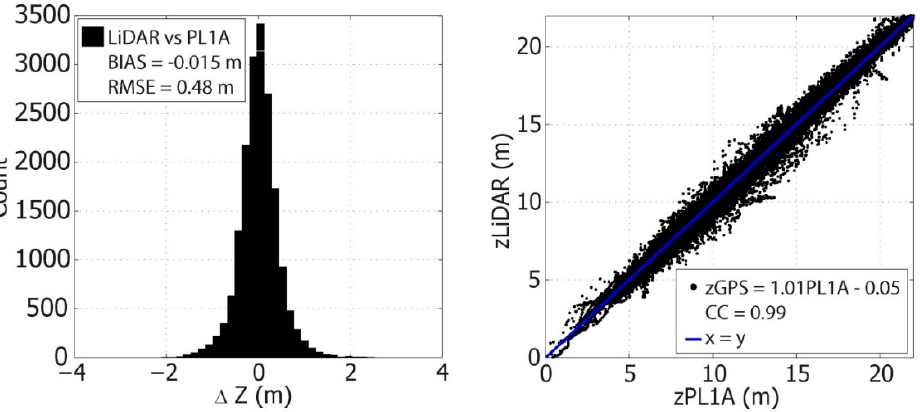
Figure 7. Pleiades (PL1A) topographic measurements accuracy assessed by comparison with LiDAR topographic measurements over points collected along 266 transects.